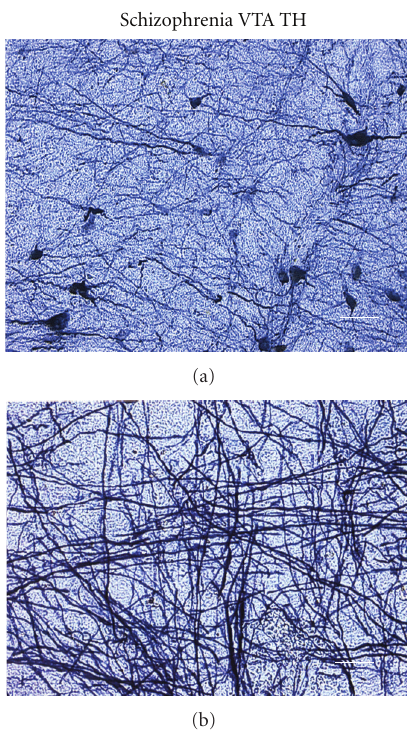
Figure 1: An image synthesized by AxioVision from a 50 µ m thick TH-stained section of the ventral tegmental area (VTA) of a 75-year-old female patient with disorganized type of schizophre- nia from a pathological autopsy. TH-ir fibers were magnifies in (b)/(a,b) TH-ir neuronal cell bodies have irregular shape, including multipolar-, triangular- or oval-shaped, and various size (6–24 µ m in diameter) (Figure 1(a)). The stainability varies between the neuronal cell bodies. TH-ir neuronal processes had irregular thickness (Figure 1(a)), curved shape having many corners (Figure 1(a)), straightened (Figure 1(b)), or are composed of fiber bundles (Figure 1(b)). These morphological findings of TH-ir neurons in the VTA were also seen in the substantia nigra of schizophrenia (not shown). Bars: Figure 1(a): 25 µ m, Figure 1(b): 12.5 µ